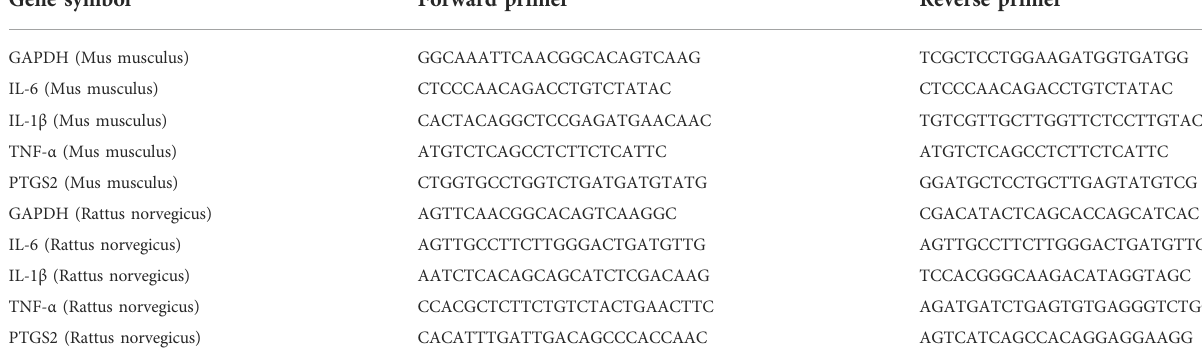
TABLE 1 Table of primers sequences for Real-Time